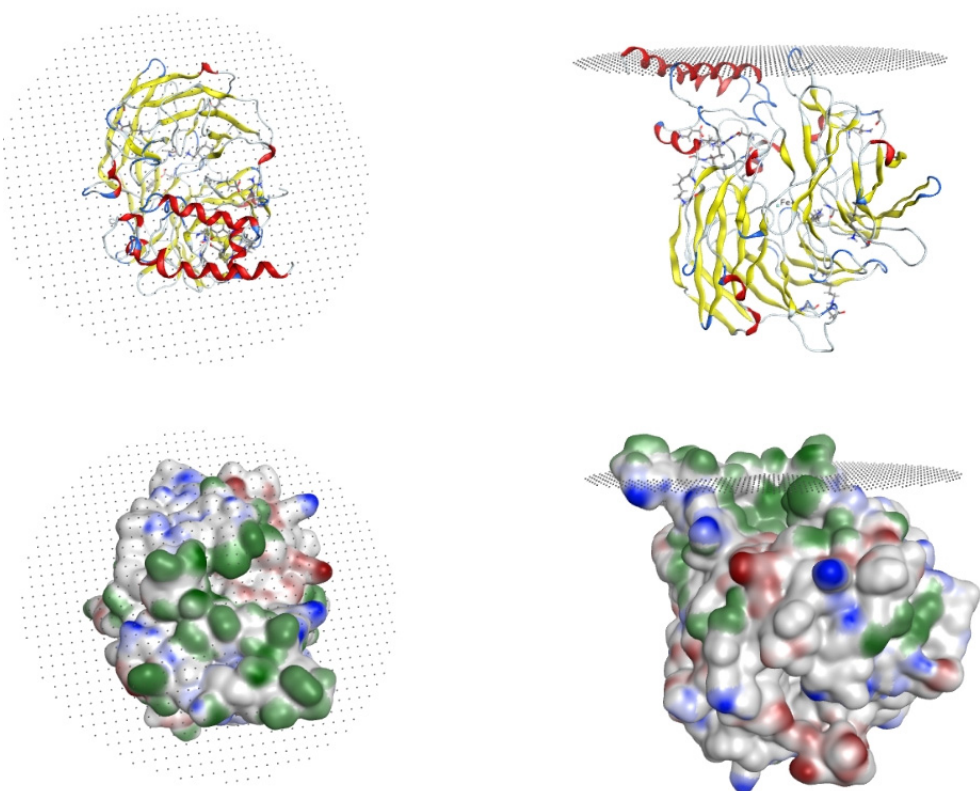
Figure 3. ( Top ) Ribbon representation of CCD4b model inserted in the membrane (dotted grey surface). ( Bottom ) Molecular surface representation colored by hydrophobic (green), negatively charged (red), and positively charged (blue) areas. Table 2. Values of the angle of inclination of the proteins’ first principal axis of inertia with respect to the membrane plane, of the depth of penetration in the membrane, and of the free energy of transfer from the solvent to the membrane ( Δ G transfer ).